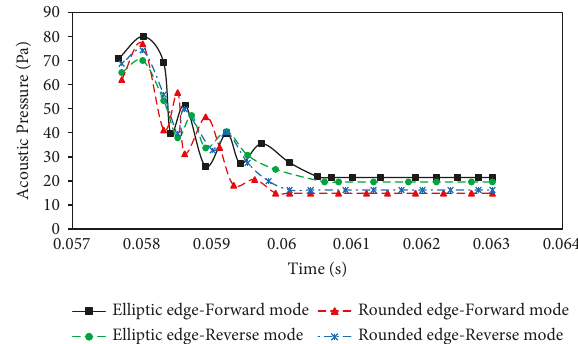
Figure 20: CFD results of the acoustic pressure vs. time at the receiver at an inlet velocity of 83.33m/s (train speed of